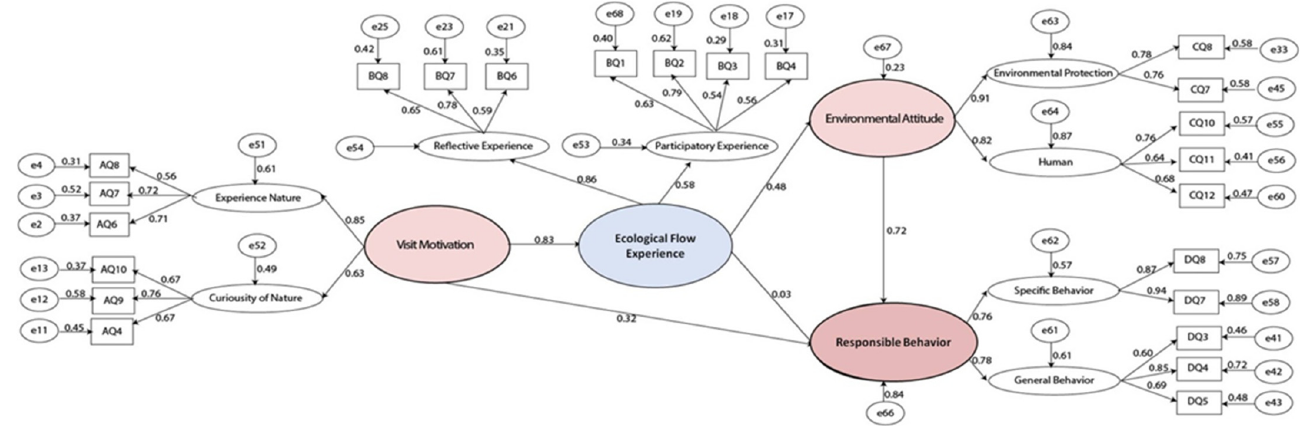
Figure 4. Final structural model.